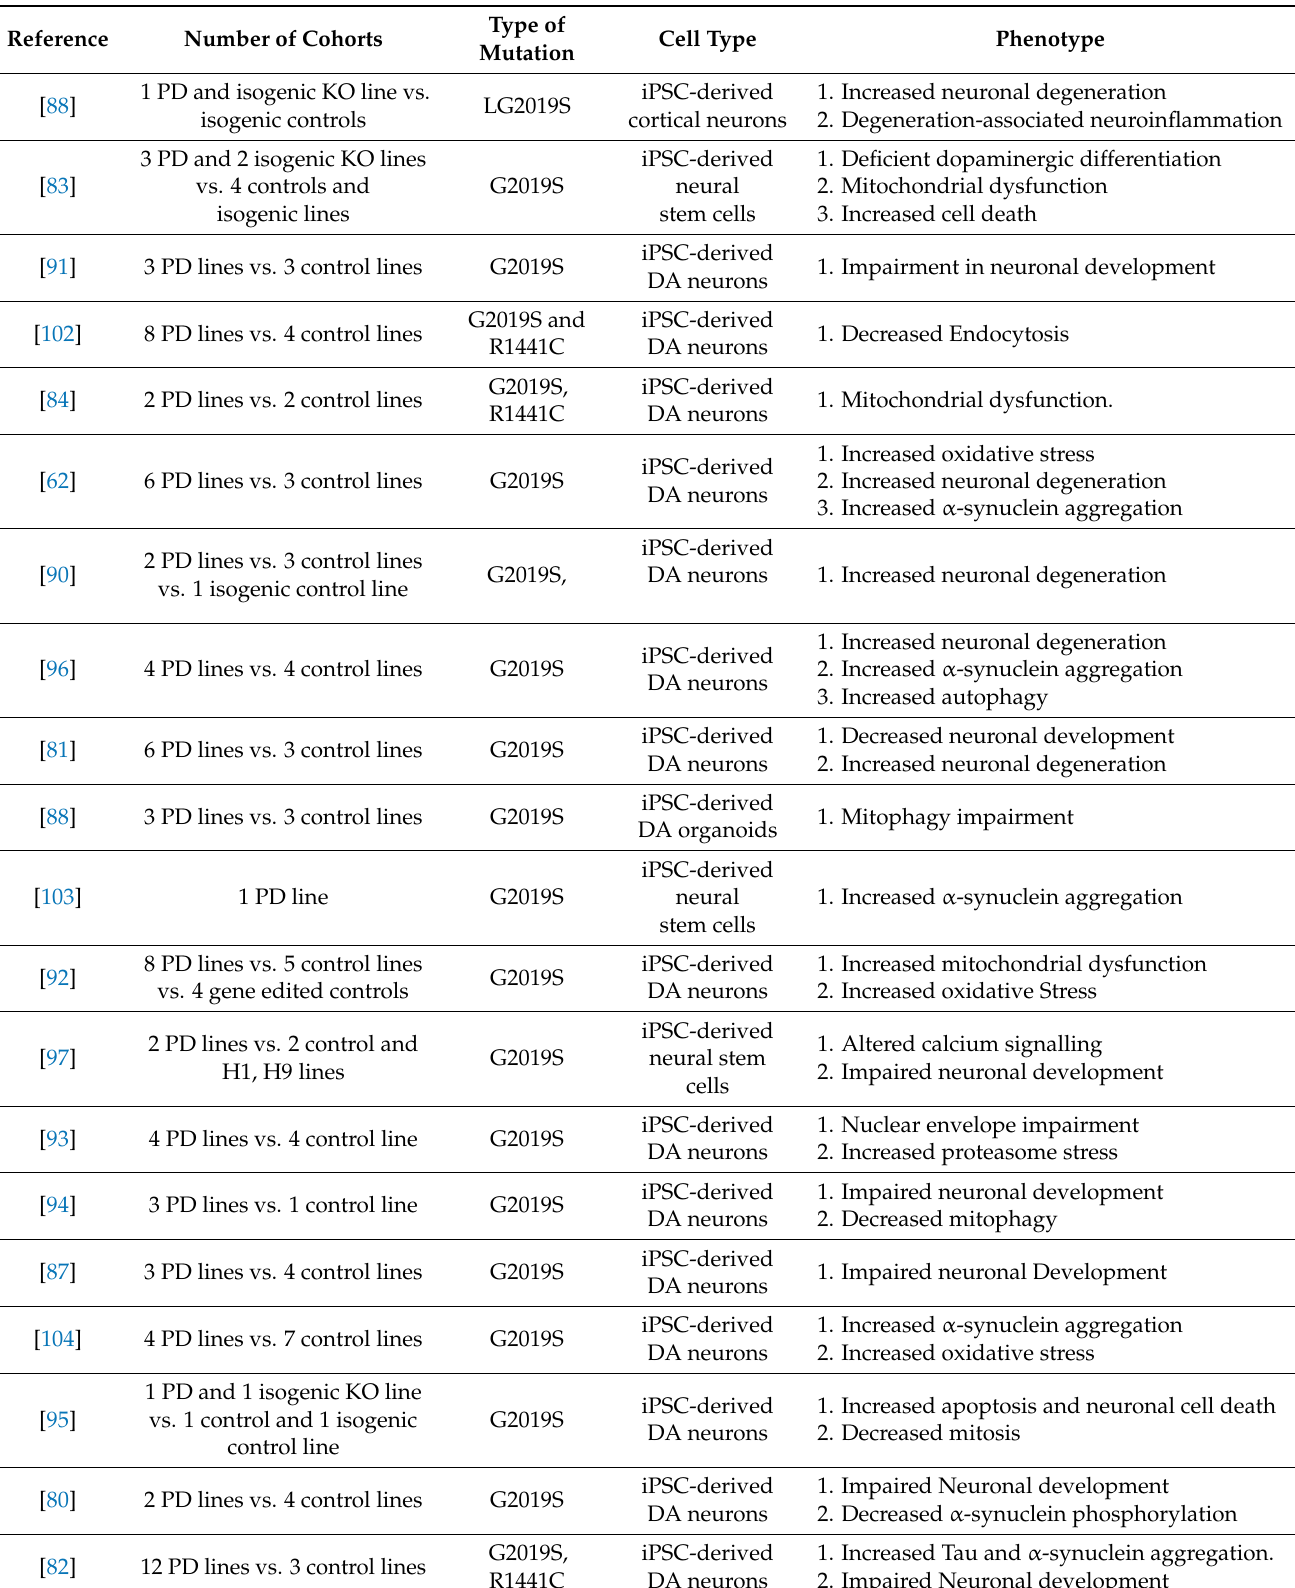
Table 2. LRRK2-mutated iPSC-derived neuronal